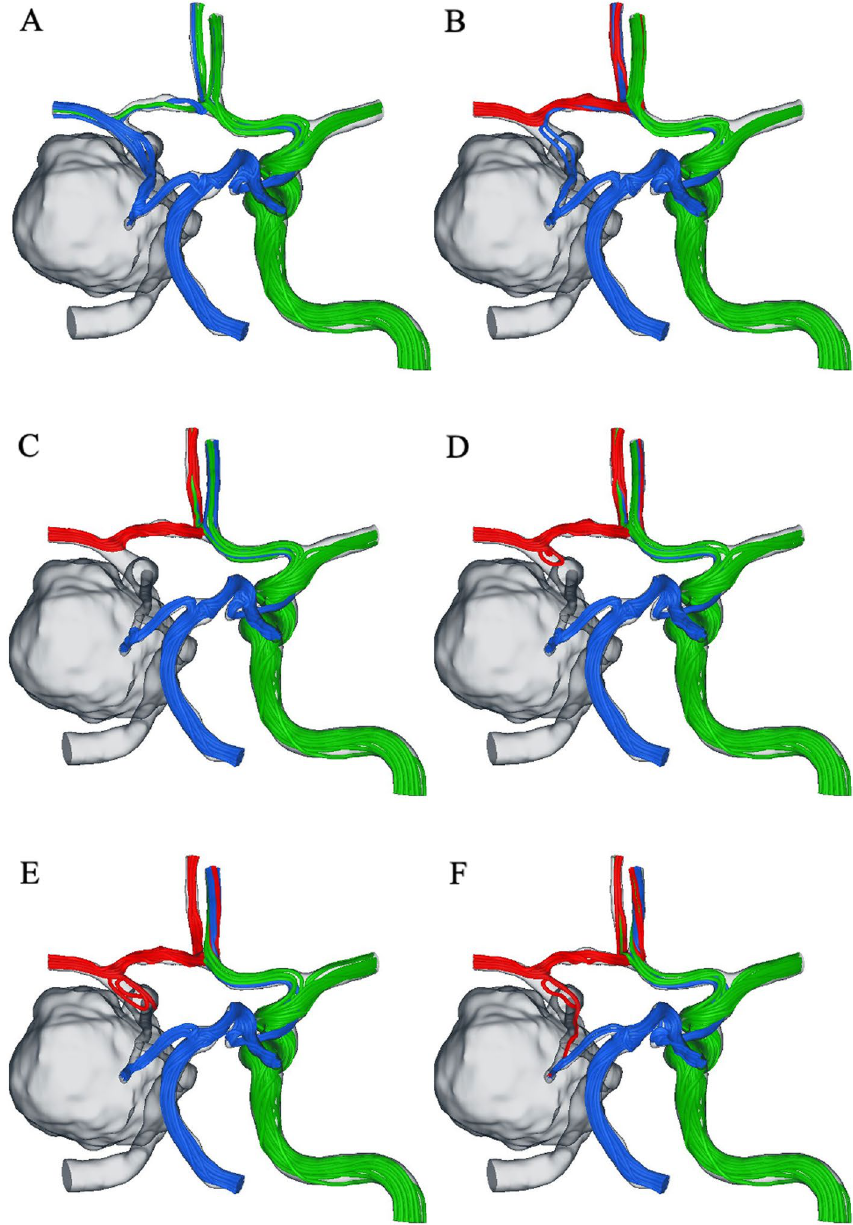
Figure 1. Streamlines are color-coded based on their origin: (red) bypass (right middle cerebral artery, MCA), (blue) BA, and (green) right internal carotid artery. ( a ) right ICA clipped; (b–f) bypass to the right MCA. The bypass flow rates were 25 ml/min, 45 ml/min, 50 ml/min, 75, and 100